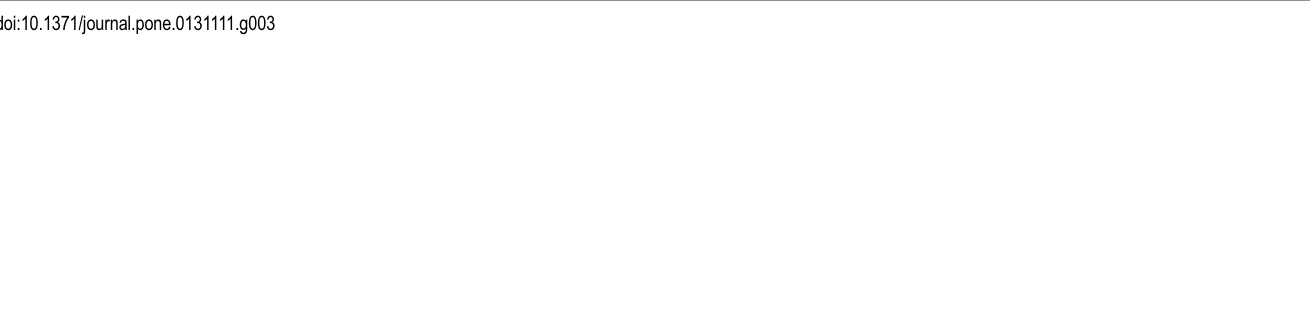
PLOS ONE | DOI:10.1371/journal.pone.0131111 July 10,